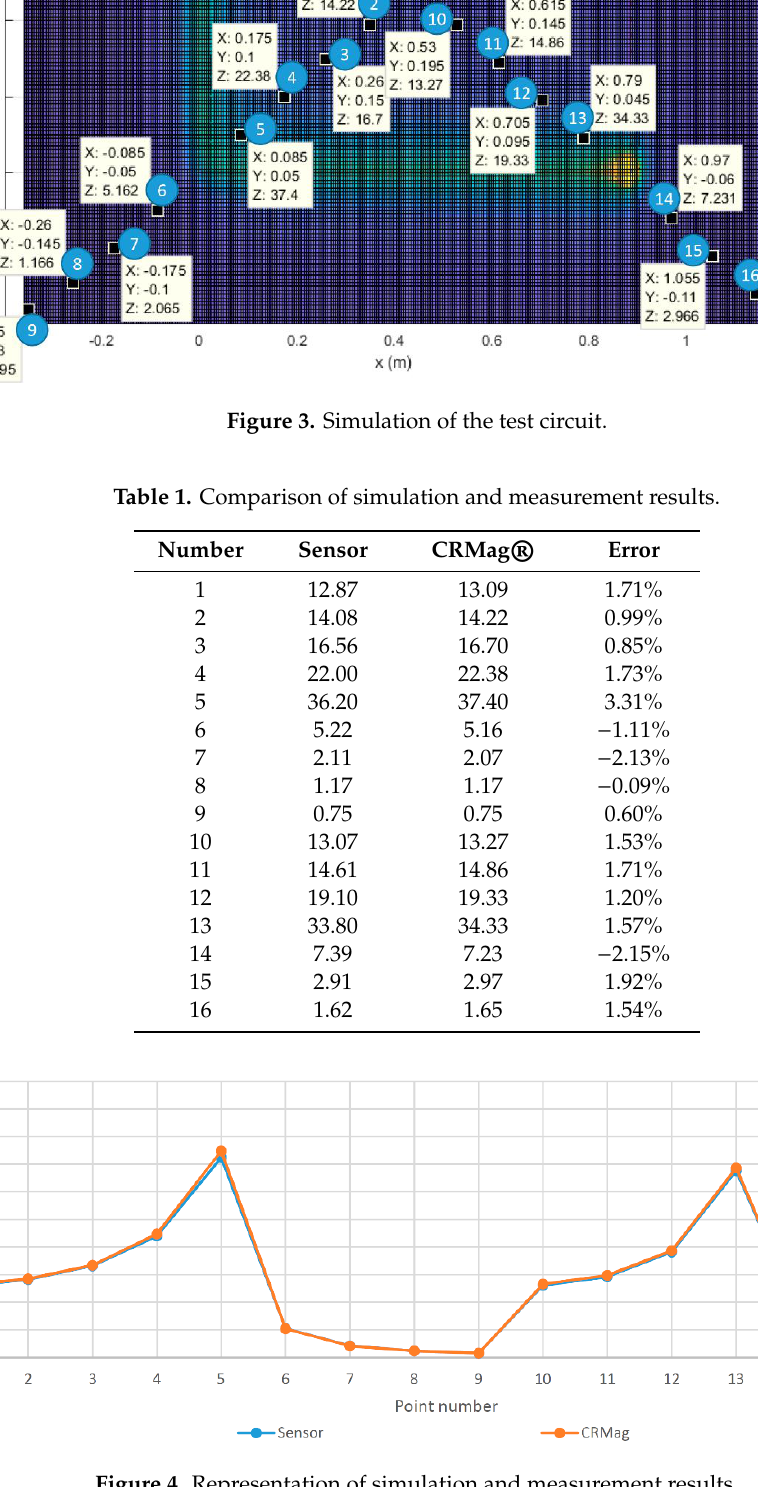
Figure 4. Representation of simulation and measurement results. Table 2. Three-dimensional H / E fieldmeter ESM-100 Maschek technical data.